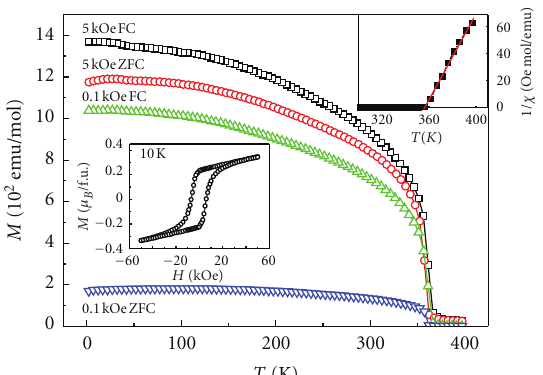
F 2: Temperature dependence of magnetization in magnetic �elds of 0.1 and 5kOe. e le� and right insets show the isothermal versus T plot of the FC data at magnetization curve at 10K and 0.1kOe, −1 𝜒𝜒